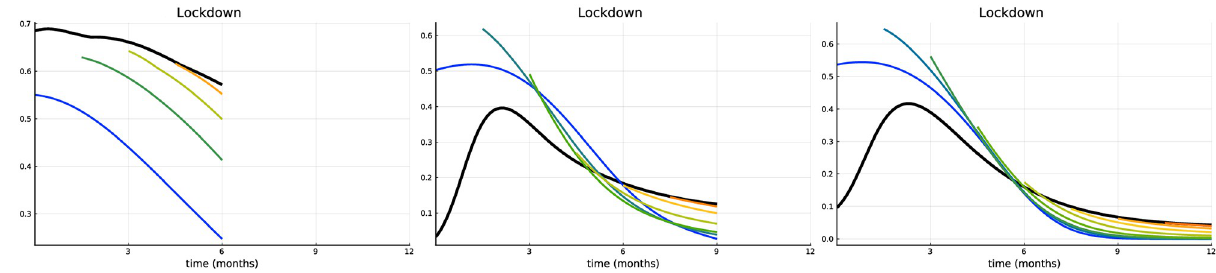
Fig 10. (iii) Finite time horizon. Lockdown intensity with time horizon of six months (left), nine months (middle) and one year